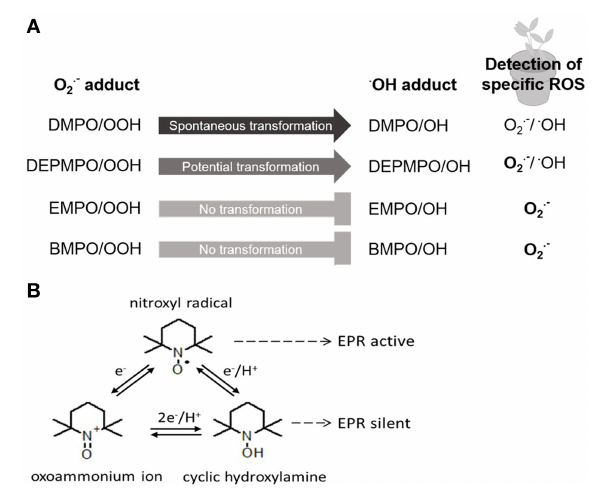
FIGURE 1 | Principles of spin trapping and spin probe method. (A) Spin trap DMPO and its analogs DEPMPO, EMPO, and BMPO are differentially used for detection of specific ROS via EPR in planta . Detailed description in text. (B) Interconversion of nitroxyl radical allows two principles of the spin probe technique using endogenous nitroxides or cyclic hydroxylamines for EPR analysis. Detailed description in text.